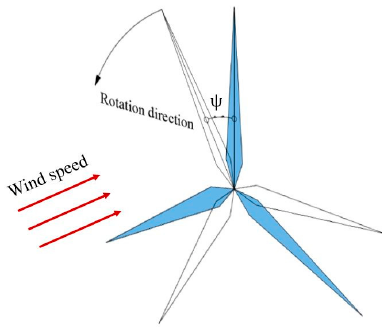
Figure 8. Definition of the azimuth.